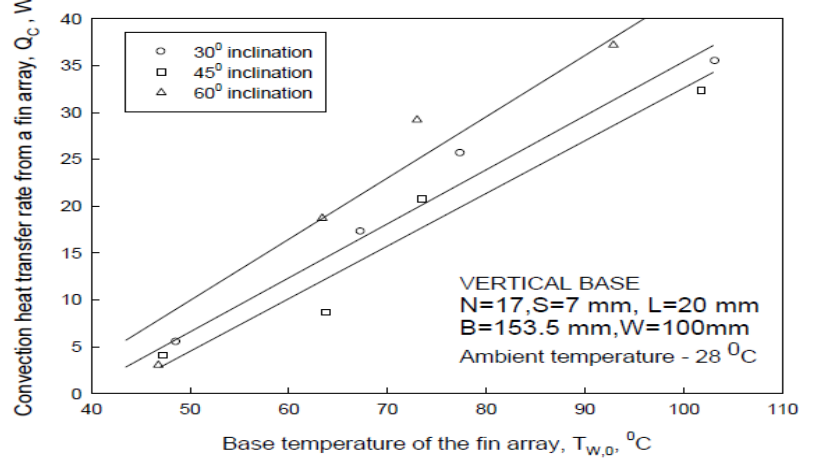
Figure 11: Effect of inclination on convection heat transfer rate from a fin array [76]